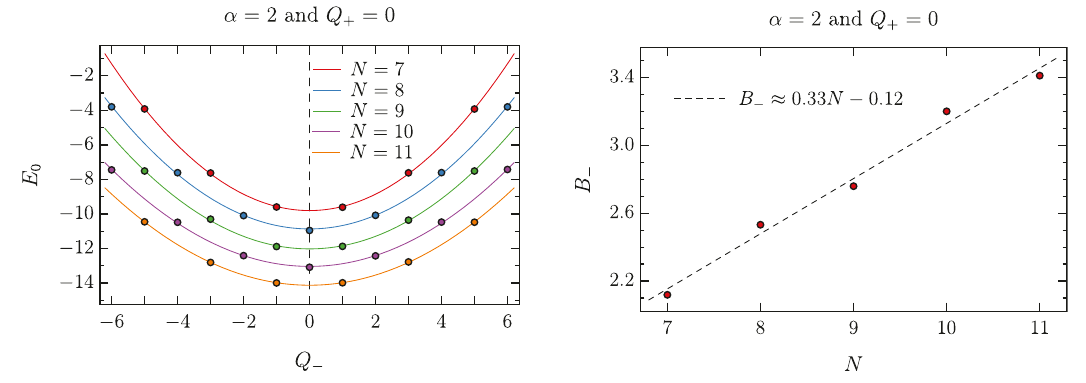
Figure 10 . The E ( Q ) curve(left) at α = 2 for the first few Q − sectors at Q + = 0 . The slope of the plot of B − vs. N is K ED ≈ 0 . 33 , which is not far from the DS calculation of K DS −